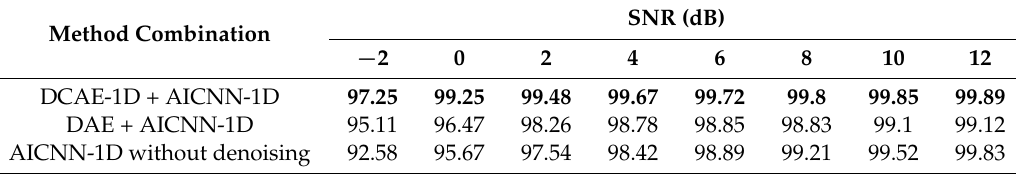
Table 12. Diagnosis accuracy of AICNN-1D with different denoising process (delete something).